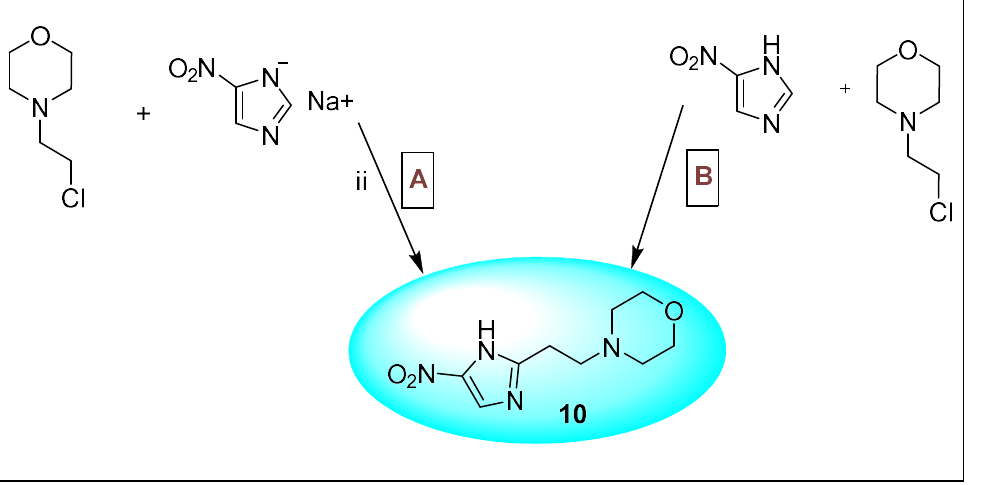
Figure 15. Activity profile of Nimorazole 11 [125,126]. *: TGDT – Tumor Growth delay time.